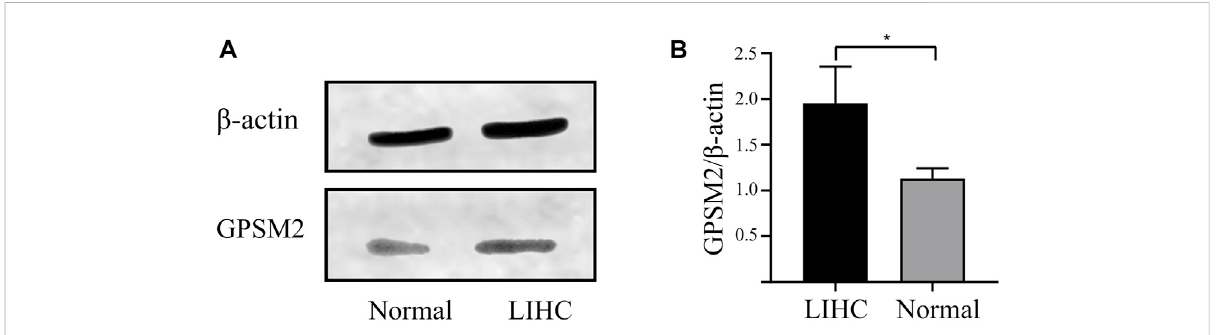
FIGURE 3 Expression of GPSM2 in human normal and LIHC tissues. (A) Protein bands of GPSM2 expression in normal and LIHC tissues. (B) Histogram of GPSM2 expression in normal and LIHC tissues.